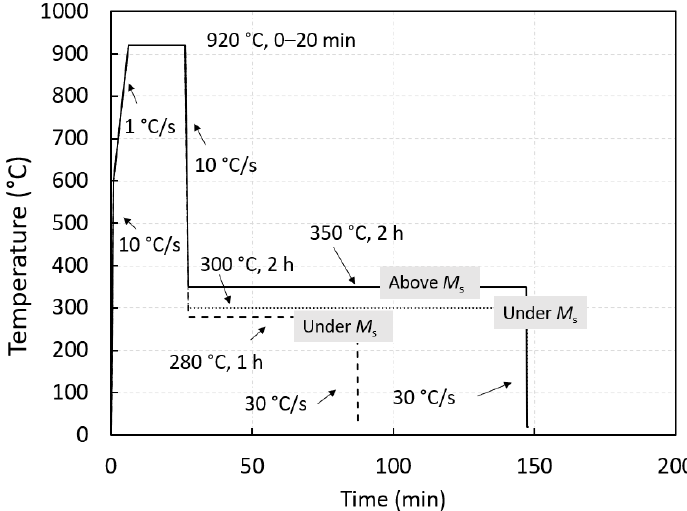
Figure 1. Dilatometric heat-treatment cycle. Ms is fixed to experimentally determined temperature.